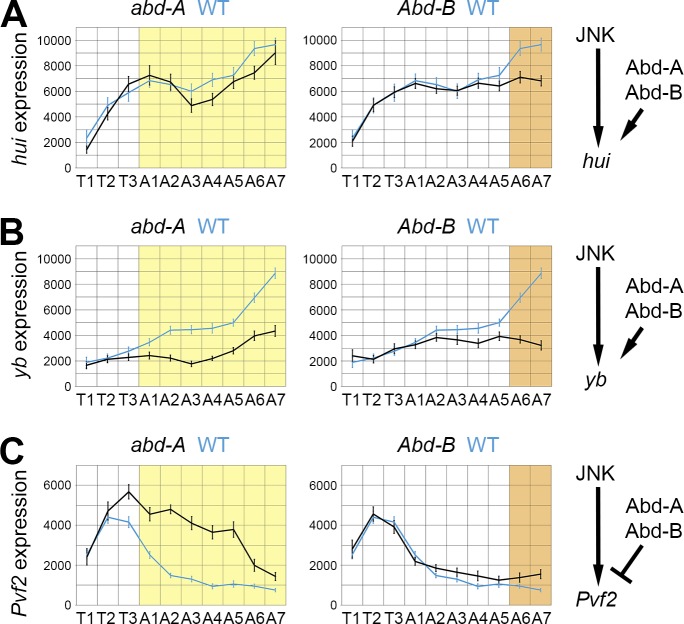
HOX regulation of other JNK target genes.Quantification of the expression (fluorescent intensity; a.u. +/- s.e.m.; n = 15) of hui (A), yb (B) or Pvf2 (C) in abd-A (black curves; left panels) and Abd-B (black curves; right panels) mutant embryos, compared to WT embryos (blue curve). The expression domains of abd-A (yellow) and Abd-B (orange) are indicated in colour. Depending on the gene, Abd-A and Abd-B behave as activators or repressors of LE gene expression (right illustrations).